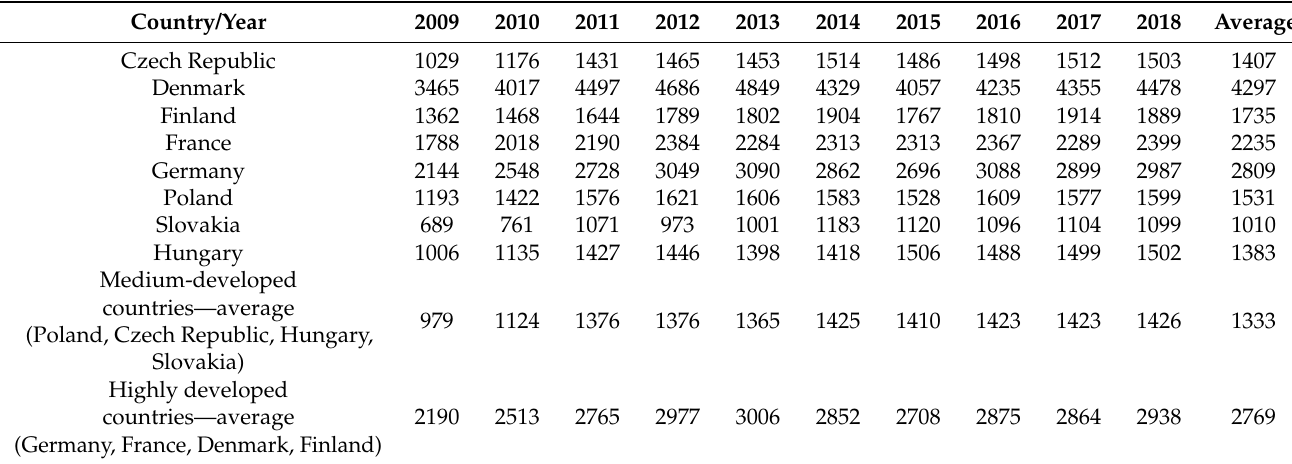
Table 8. Total income from agricultural production per hectare (ha) of utilised agricultural area (UAA) in the surveyed EU countries (in euro per ha).